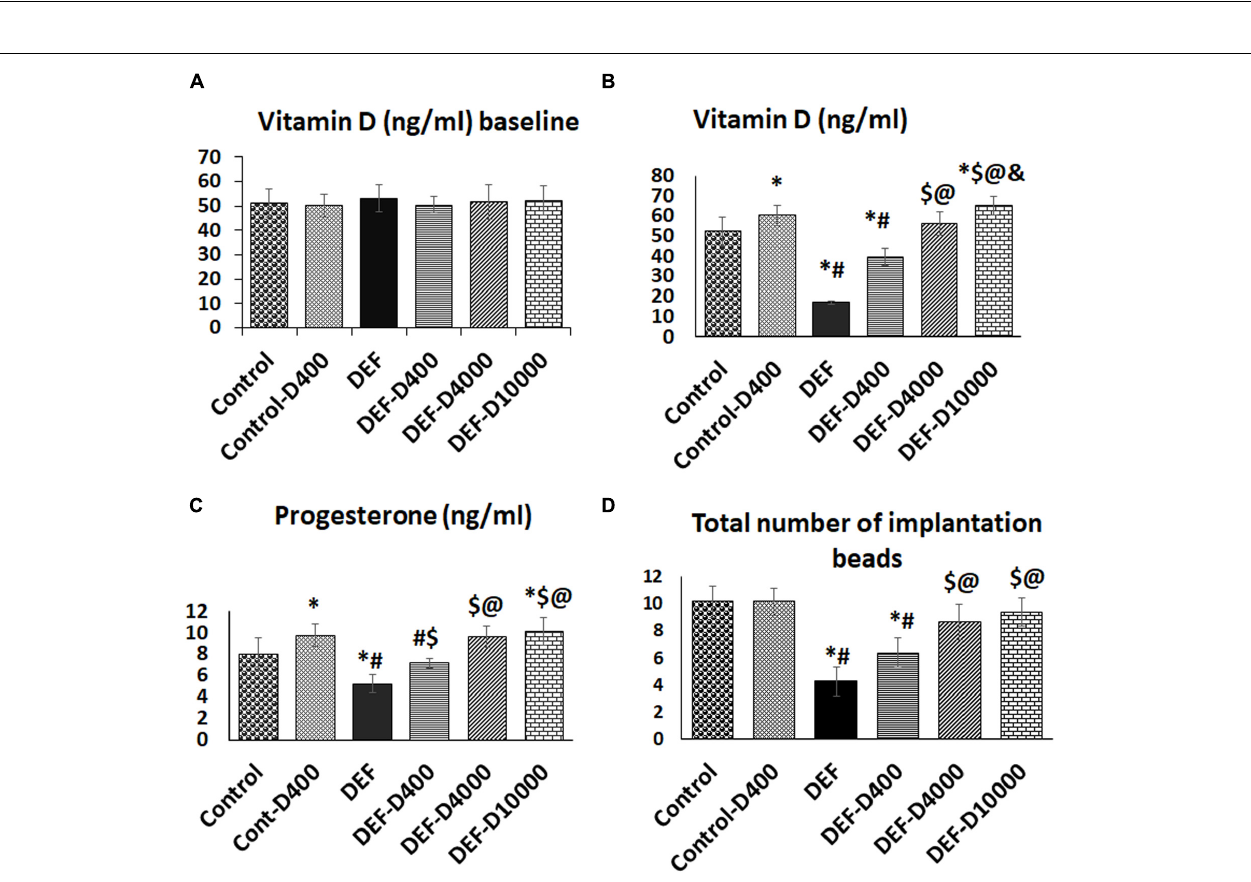
FIGURE 2 | (A) Representation of the baseline level of VD, (B) the changes in the serum VD levels at the study end, (C) the serum progesterone, and (D) the number of uterine implantation sites. D: refers to VD supplementation in different doses equivalent to 400, 4,000, and 10,000 IU. DEF: refers to VD deficiency, ∗ : A statistically significant sign compared to the control group, #: compared to control-400, $: compared to the deficiency group, @: compared to DEF-400, and &: significant compared to the DEF-4000 group ( p < 0.05).